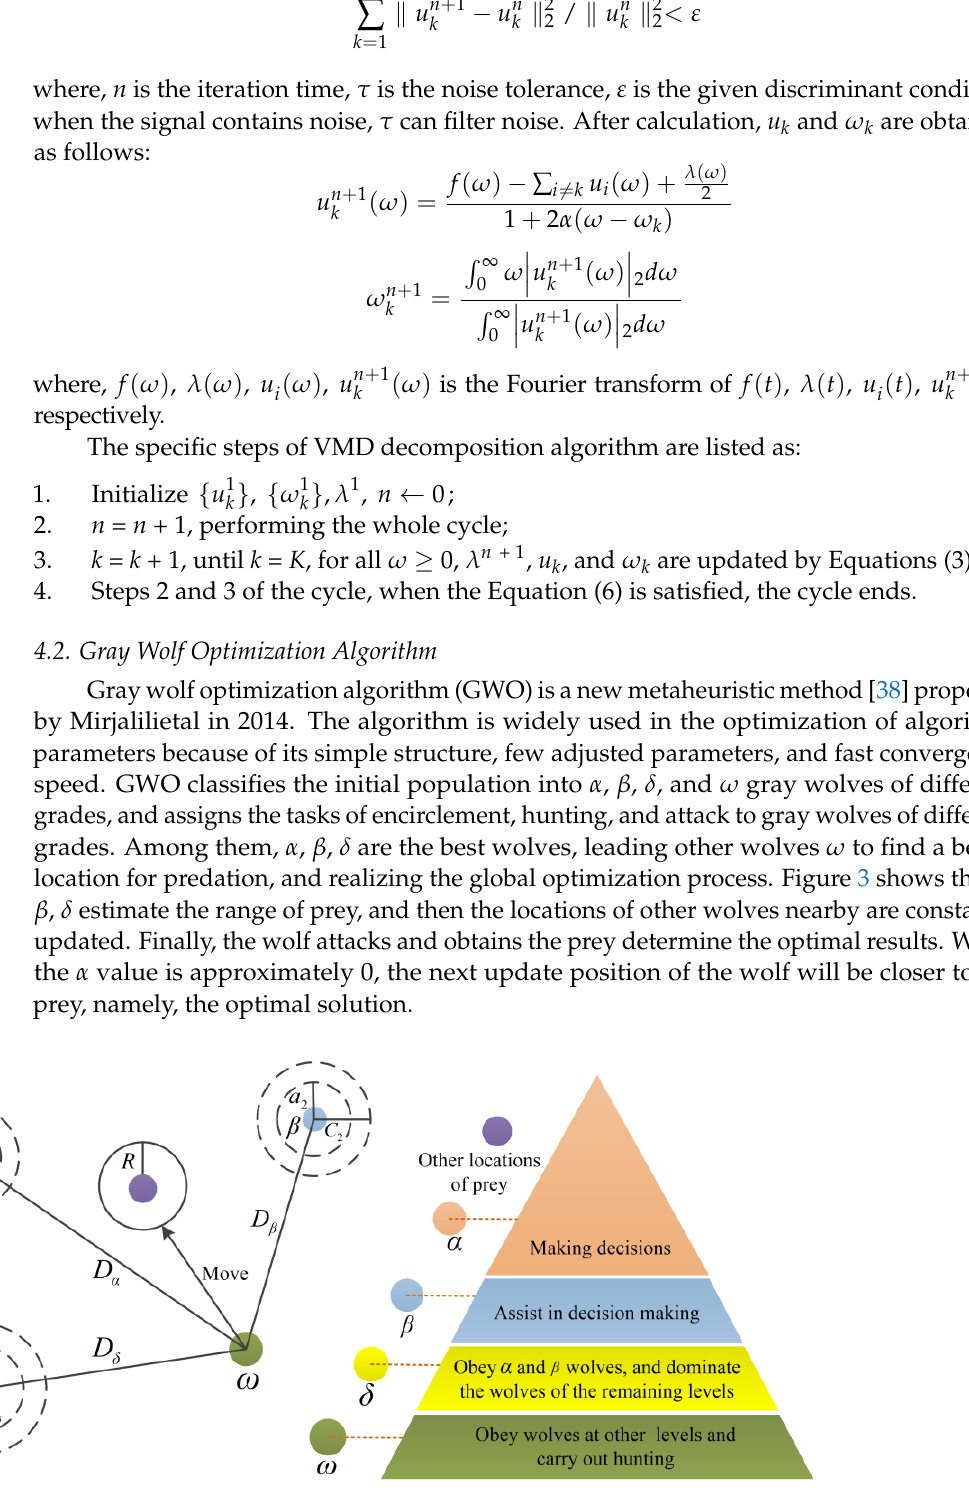
Figure 3. The hierarchical structure of wolves in the GWO algorithm.